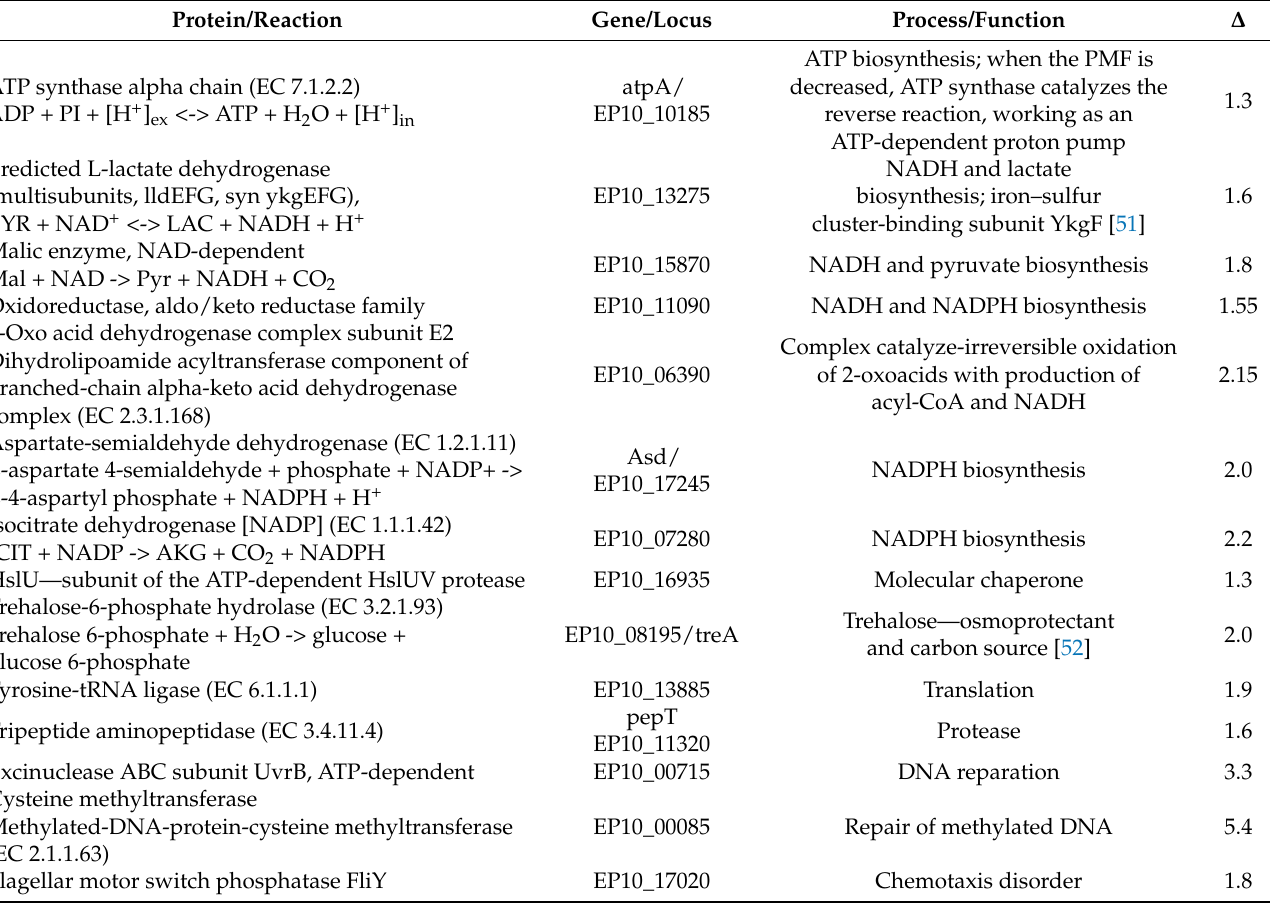
Table 2. The identified proteins whose levels significantly increased in the proteomic profile of G. icigianus after 15 min of THz